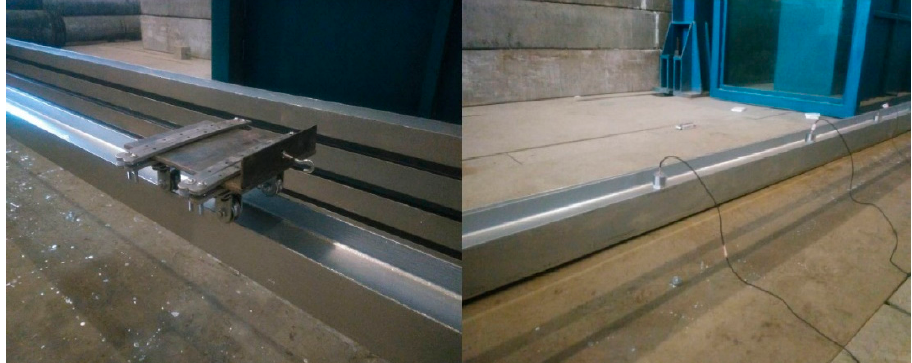
Figure 5. A general view of the vehicle and accelerometers.